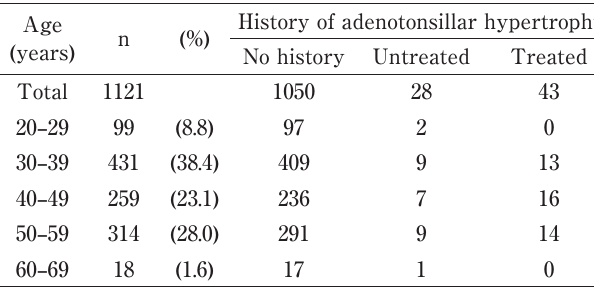
men.Table 1. Age distribution of subjects in the present study